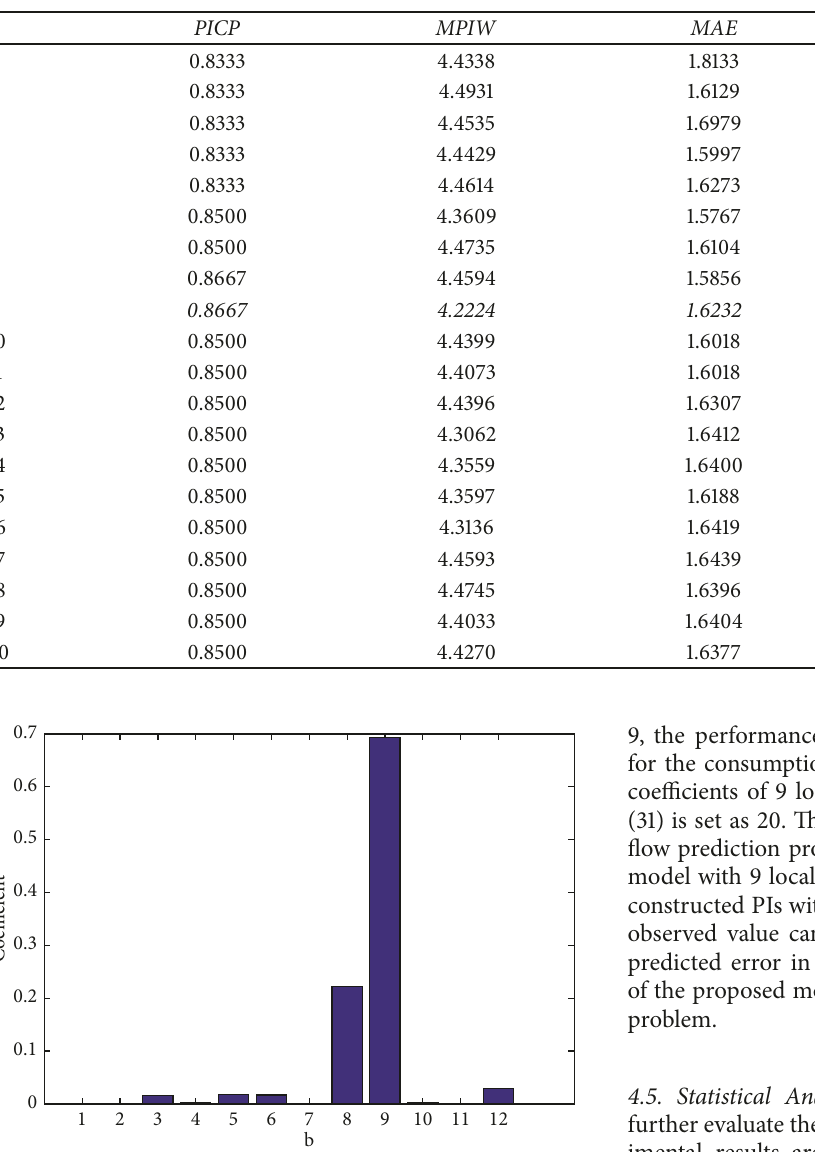
Figure 9: The histogram of the contribution coefficientof each local